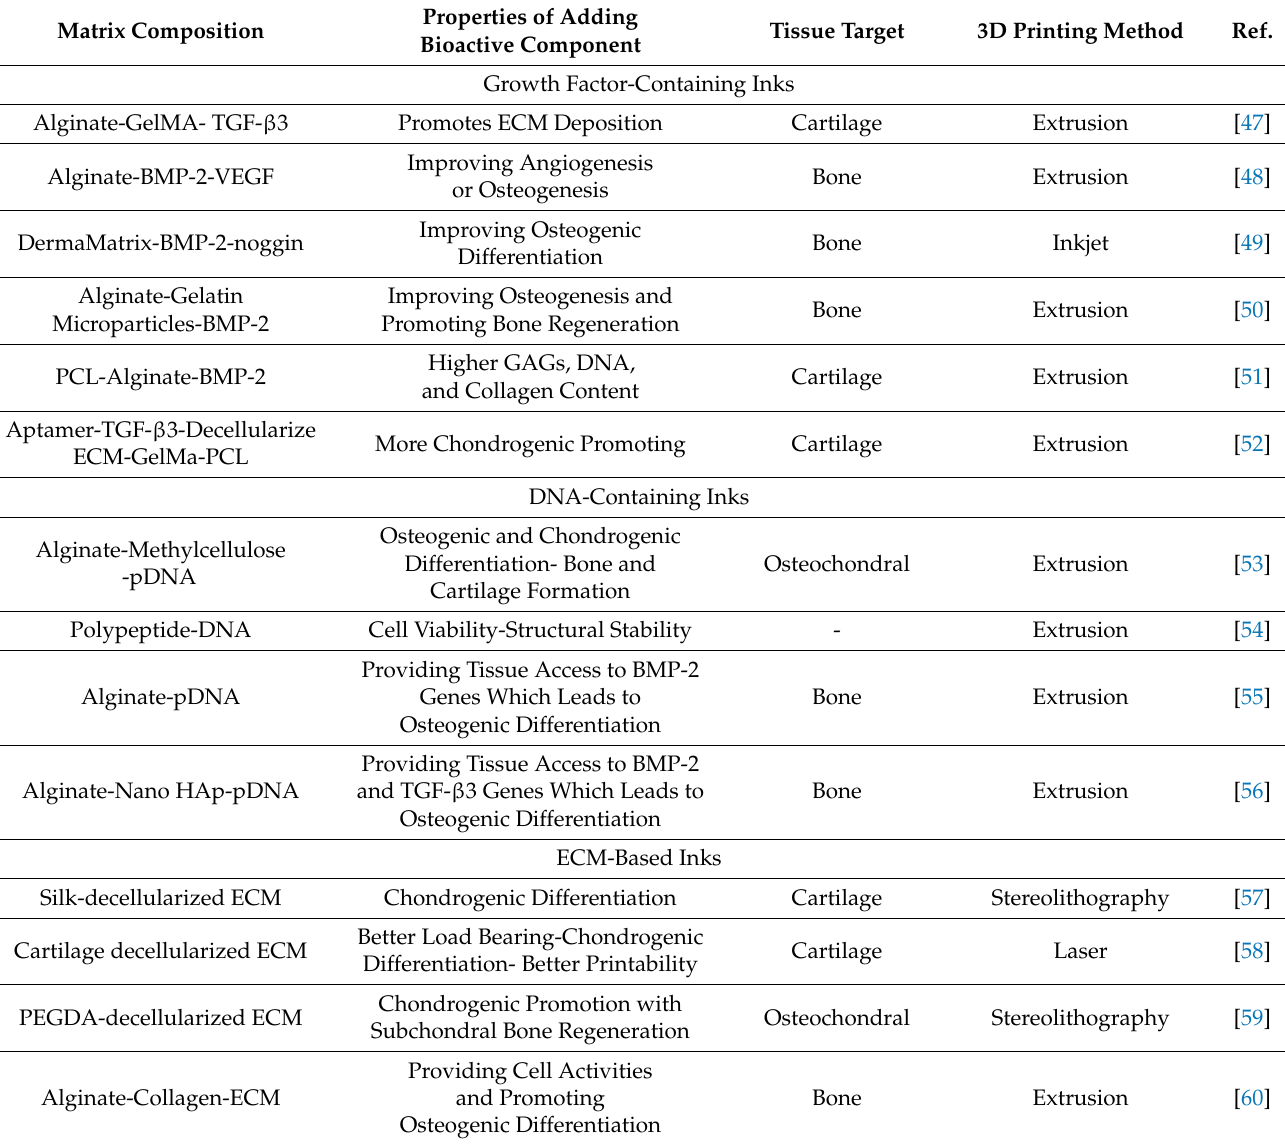
Table 1. Summary of bioactive inks for bone, osteochondral, and cartilage